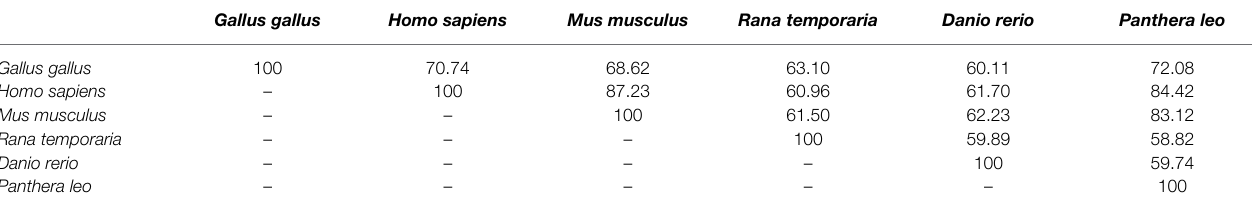
TABLE 2 | TMK domain amino acid sequence similarity of CMPK2 among different species.